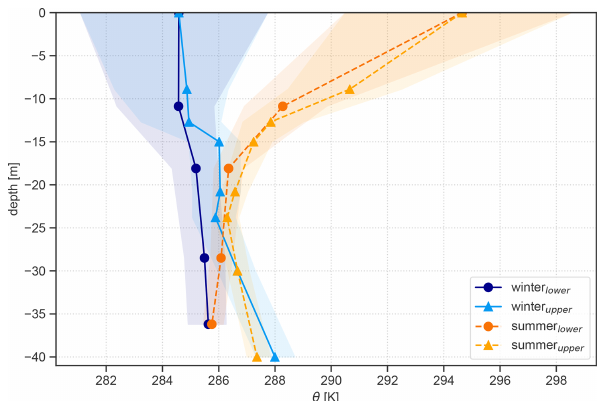
Figure 7. Averaged potential temperature profiles over the period of June 2011 to May 2014 for the summer (dashed) and winter (solid) along the upper and lower entrance. Shaded areas around these lines denote the 25% and 75% quantiles at the respective logger height. Markers indicate the loggers at the respective depth inside the cave along the lower (triangles) and upper (dots)